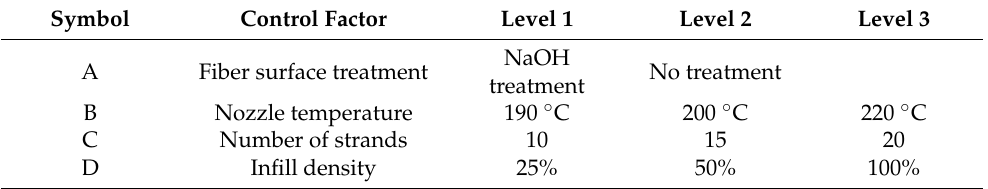
Table 1. Control factors of the composite.